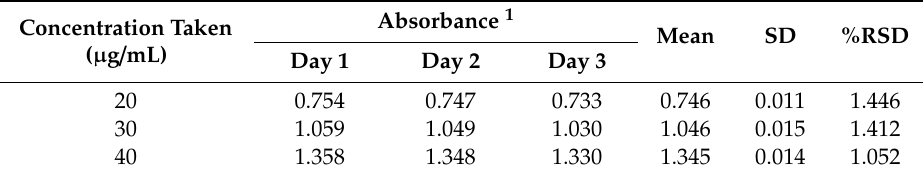
Table 9. Results of interday precision using UV-vis